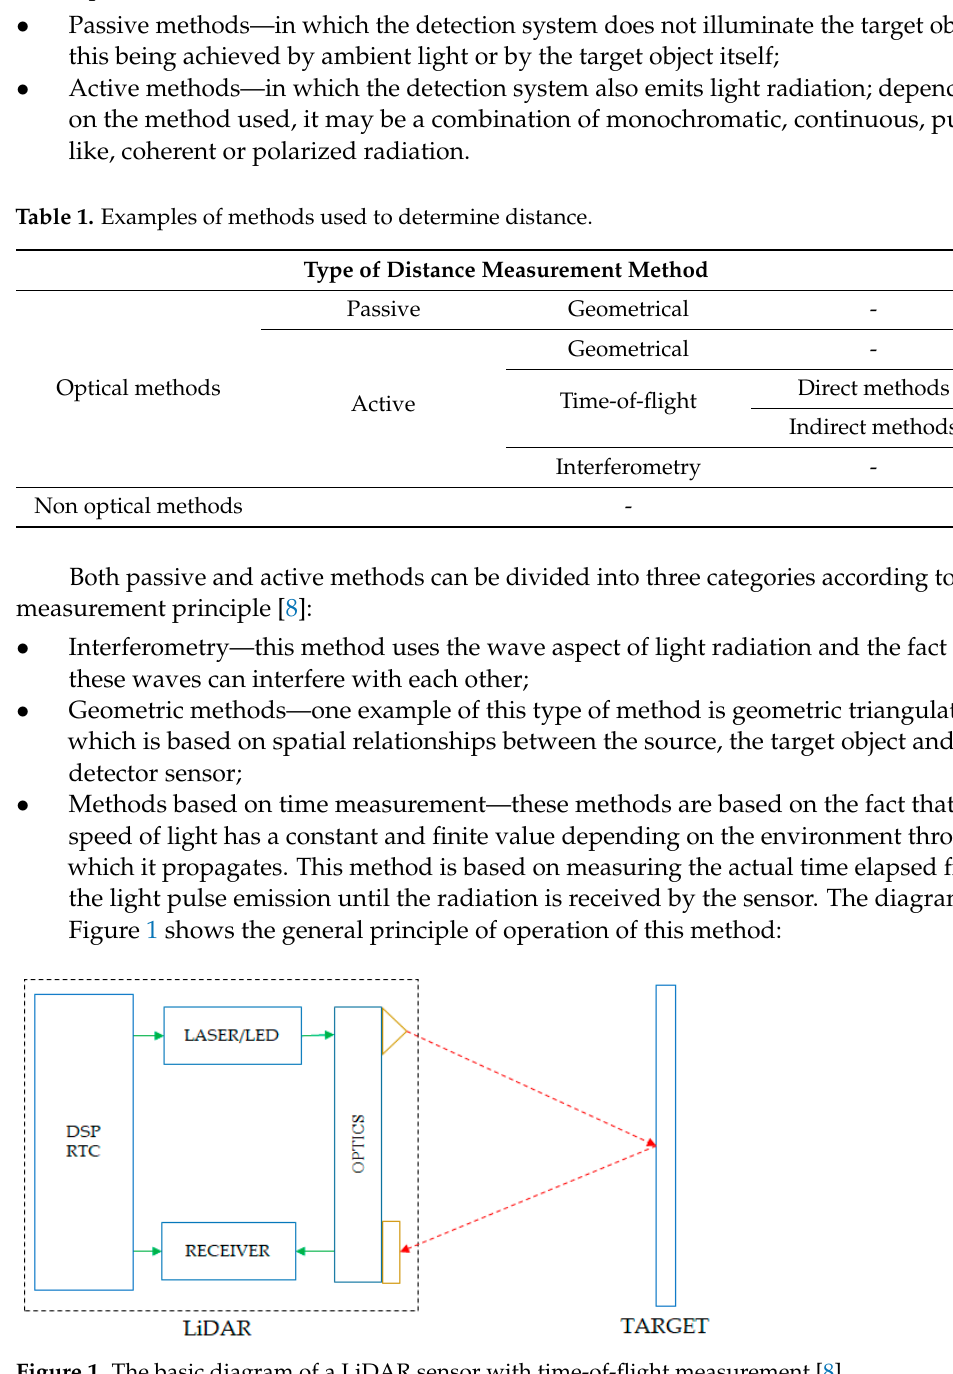
Figure 1. The basic diagram of a LiDAR sensor with time-of-flight measurement [8]. In this case, the measured distance will have a value given by Equation (1):